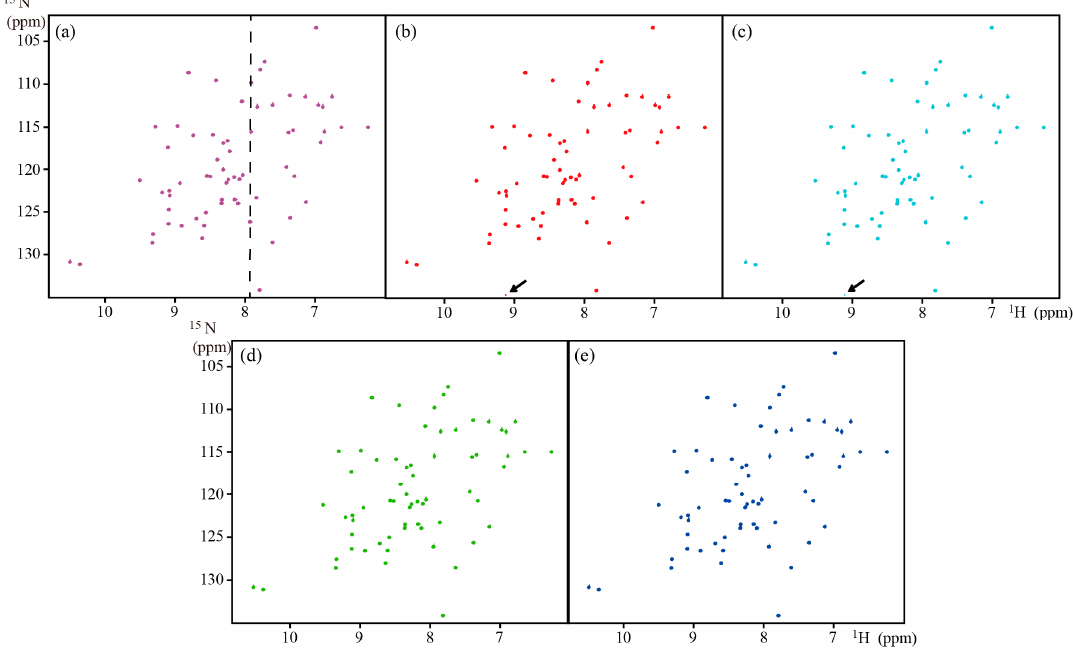
Figure 3. Reconstructed 2D HSQC spectra of GB1 with 15% NUS data. ( a ) The fully sampled spectrum; ( b – e ) reconstructed spectra using the LRHM, LRHMF, SLS, and SLSMF, respectively. Note: The contours of spectra are at the same level.